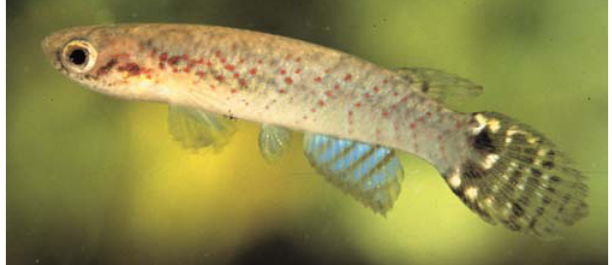
Fig. 4. Rivulus cyanopterus , UFRJ 5912, female, paratype, 21.4 mm SL (one day after collection); Brazil: Mato Grosso: Jaciara. Photo by W. J. E. M.